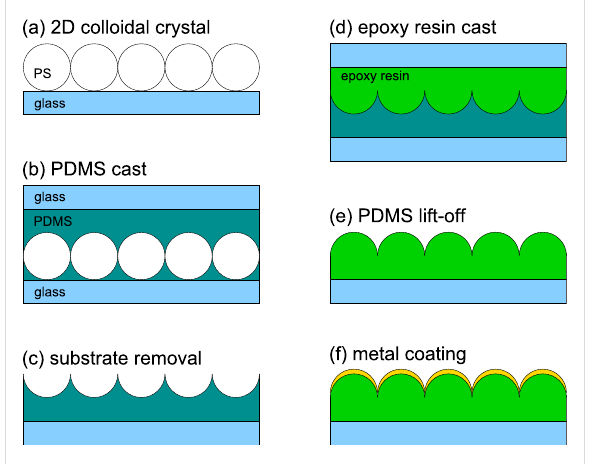
Figure 1: Fabrication of arrays of metal film coated hemispheres. Main steps: (a) Preparation of 2D colloidal crystal; (b) cast of polydimethyl- siloxane (PDMS); (c) detachment of substrate; (d) cast with epoxy resin; (e) PDMS detachment and (f) metal coating by physical vapor deposition.